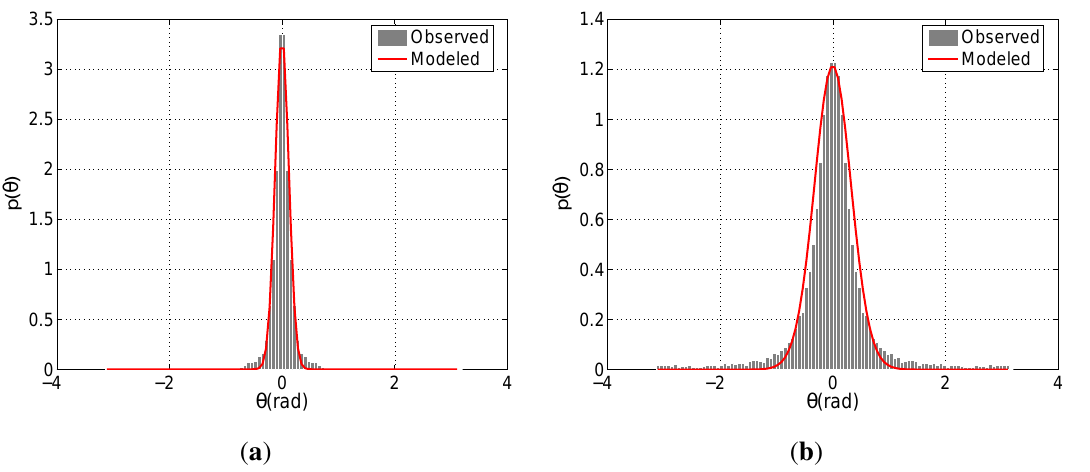
for ( a ) BIWI-ETH and G G